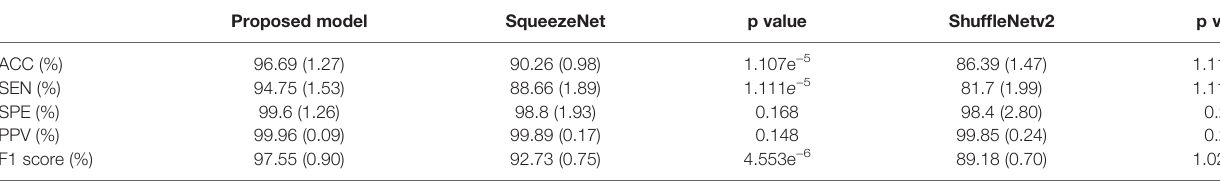
TABLE 4 | Performance of each model in 10 randomized grouping experiments.